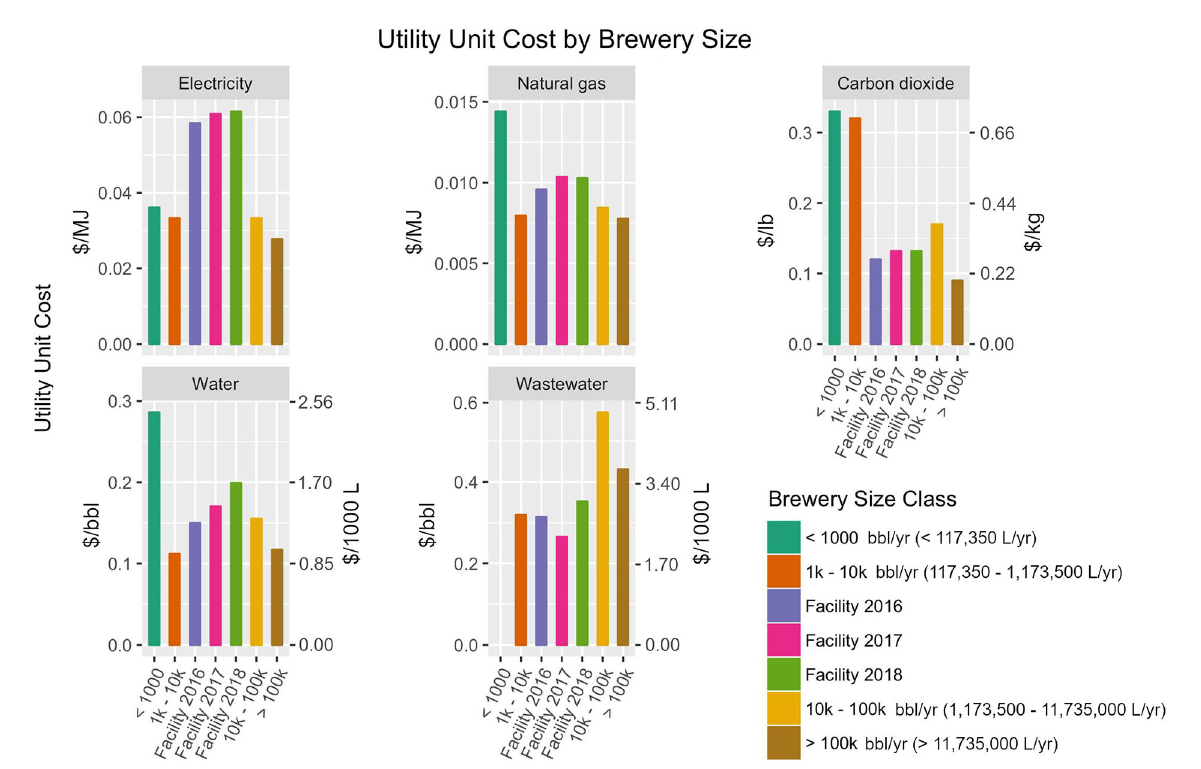
FIGURE5 Specific utility cost, in dollars per unit, for electricity (MJ), natural gas (MJ), water (bbl), CO2 (lb), and wastewater discharged (bbl) [Data are not available for the mass of solid waste disposed at the case study facility. All usage ratios are per bbl packaged or per L packaged. Benchmark data are from 2014 (Brewers Association, 2016)].